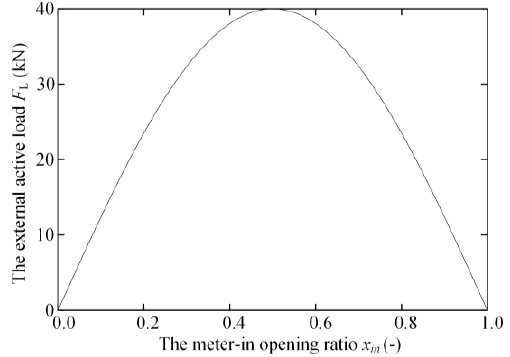
Figure 12. The external active load F L of the two systems.